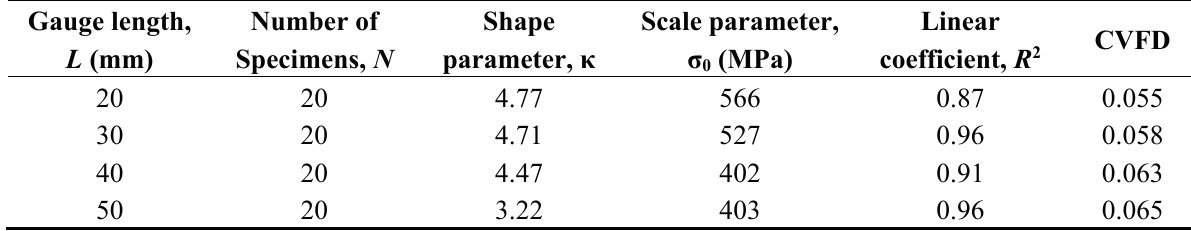
Table 1. Weibull parameters for the tensile strength of bamboo fibers at different test lengths. CVFD, coefficient of variations of fiber